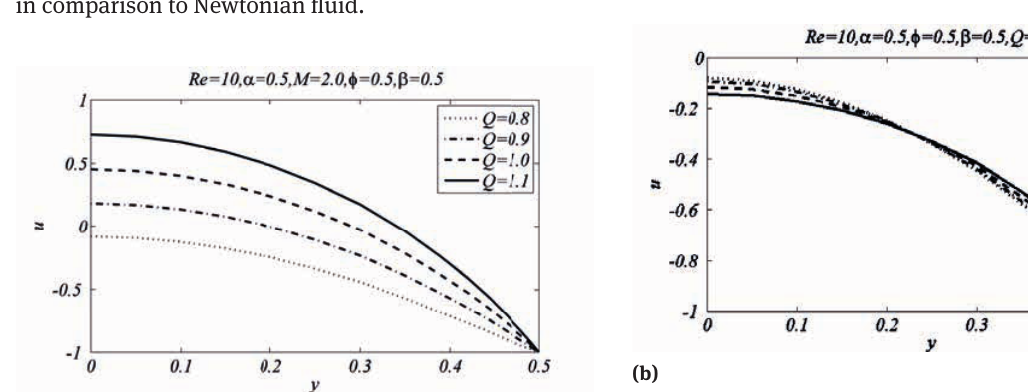
The opposite behavior is reported by increasing the Reynolds number in Figure 7. Here flow is positive near the wall up to Re =15 but for the greater value of Reynolds number a flow reversal is observed near the wall and de- creasing. On the contrary, for Casson fluid, no such flow reversal is observed up to Re = 20.